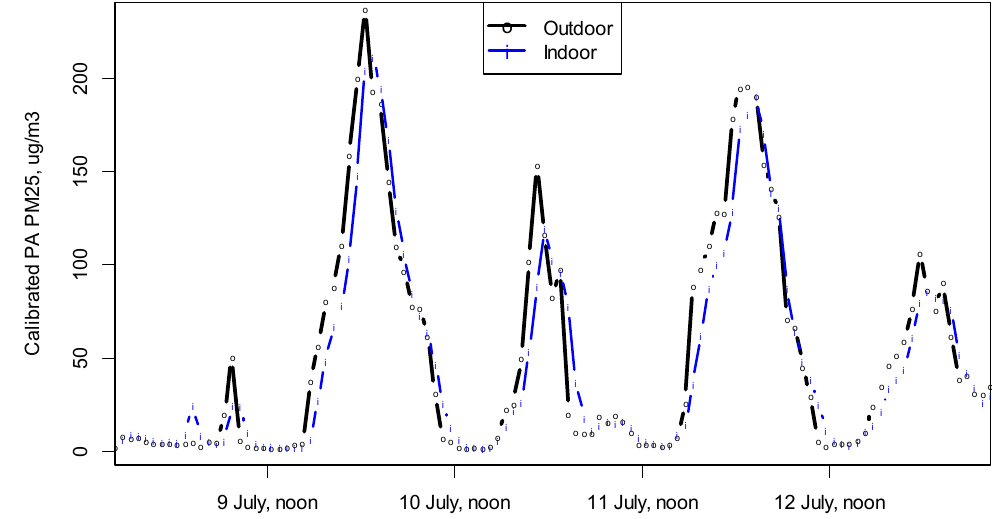
Figure A2. Comparison of hourly average PM 2.5 inside and outside a house in south